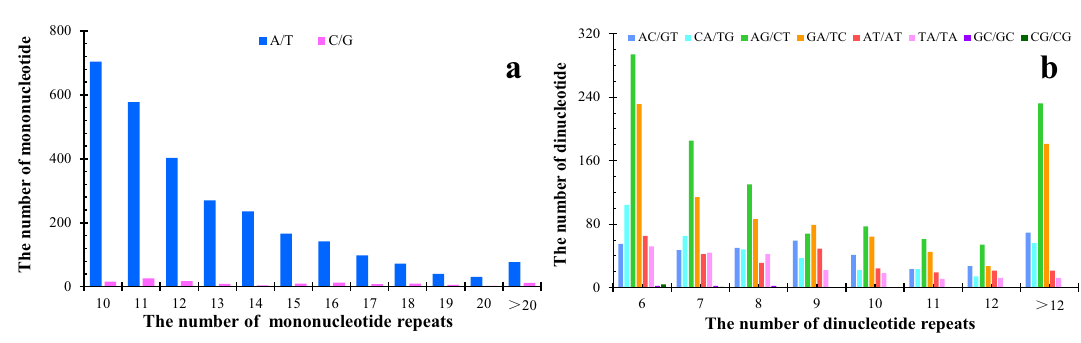
Figure 6. The types and numbers of mononucleotide and dinucleotide repeat